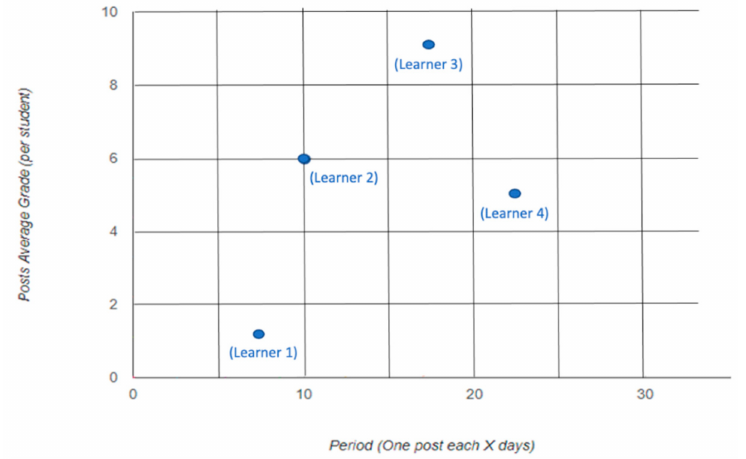
Figure 1. Chart representing the quantitative dimension (period) ( x -axis) and relevance (post average grade) ( y -axis), with four example learners (four blue